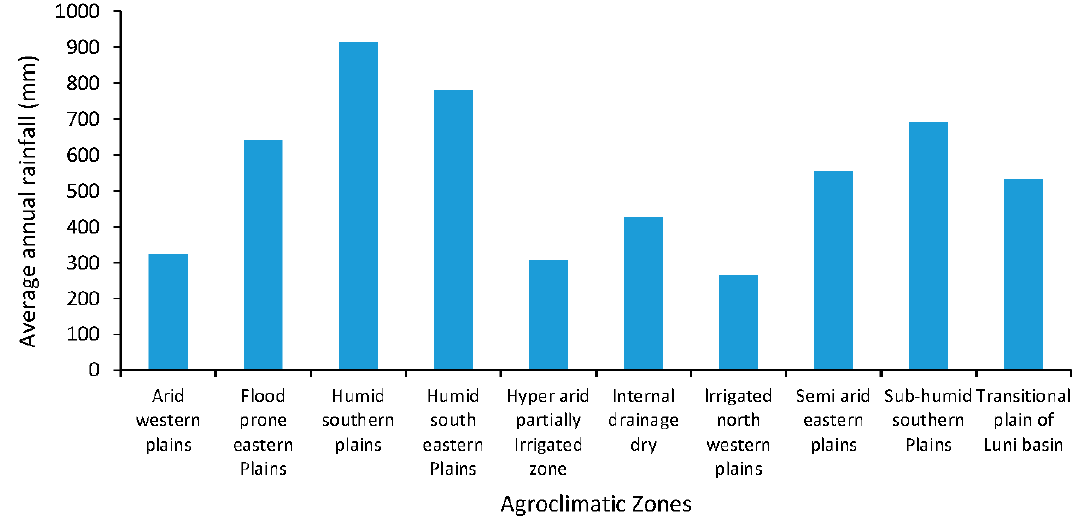
Figure 5. Agroclimatic Zone average annual rainfall hyetograph in Rajasthan from 2004 to